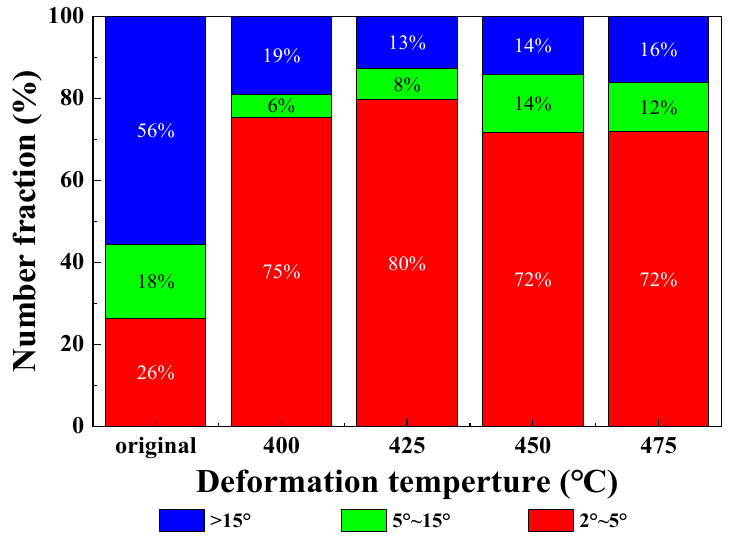
Figure 13. Reverse polar diagrams at different temperatures.